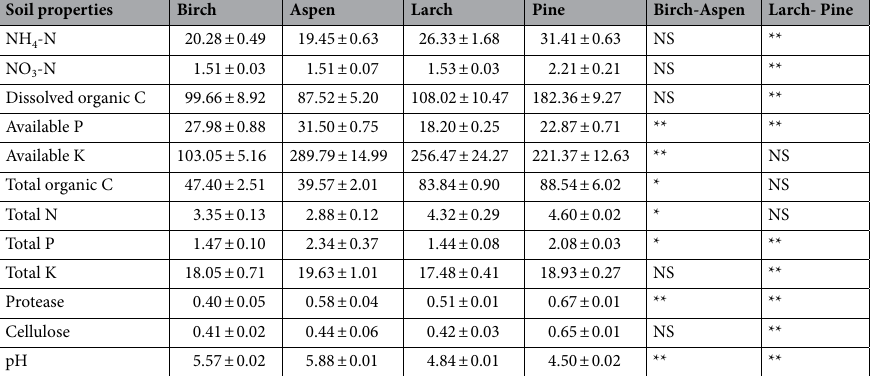
Table 1. Soil properties in southern boreal forests in Greater Khingan Mountains. Ammonium nitrogen (NH 4 -N); nitrate nitrogen (NO 3 -N); C, N, P, and K are common abbreviations of elements. Units are g/kg for contents of total organic C, total N, total P, and total K; while mg/kg for other nutrient contents. Meanings